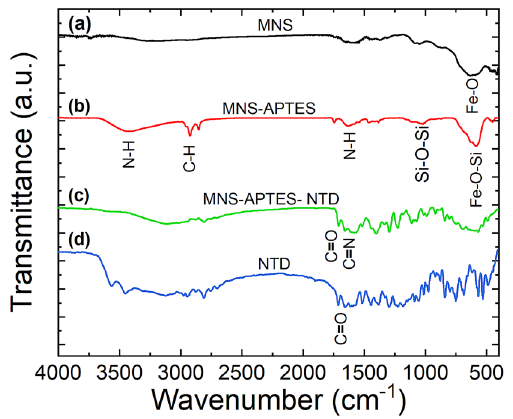
Figure 2. FTIR spectra of ( a ) MNS, ( b ) MNS-APTES, ( c ) MNS-APTES-NTD, and ( d )